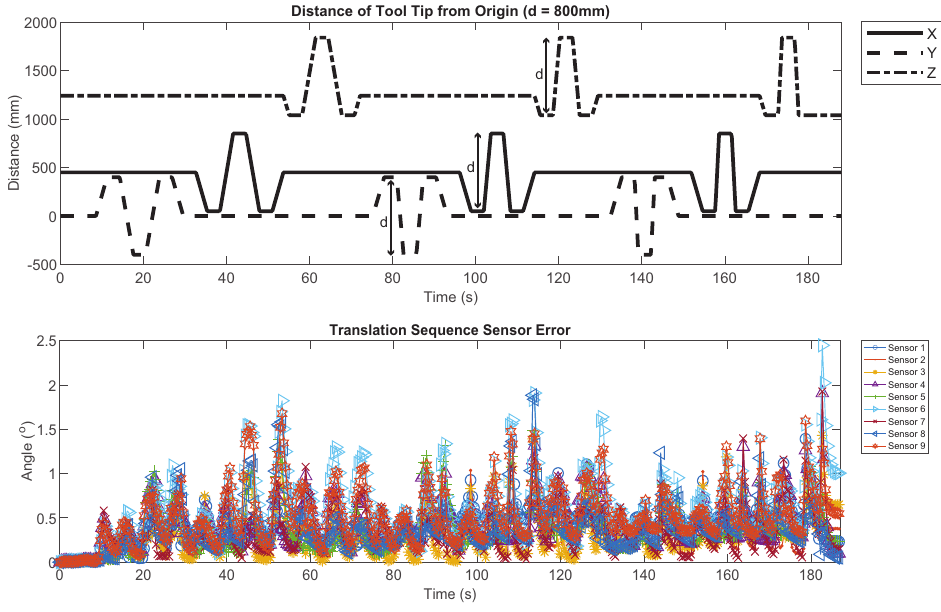
Figure 4. The programmed position of the tool center point (TCP) in mm from the point of origin defined by the IRB 2600, using the local coordinate system of the IRB 2600 ( top ). Translation error of the individual IMUs fused with the Kalman filter without the magnetometer ( bottom